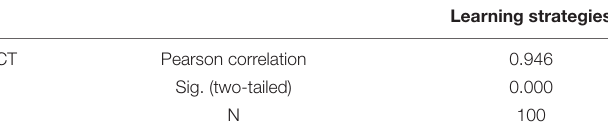
TABLE 5 | Pearson correlation: CS, MS, SS, AS, CS, and MS with writing performances.